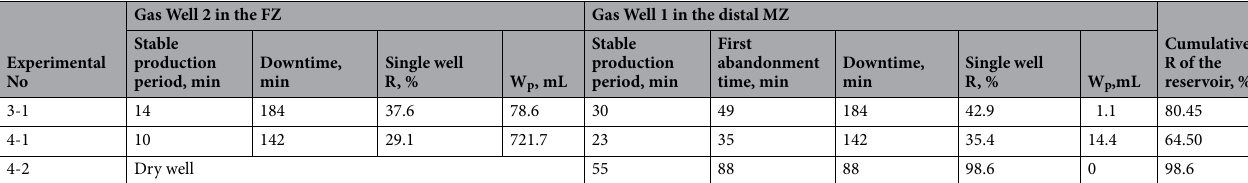
Table 12. Statistics on the production of Group IV and Experiment